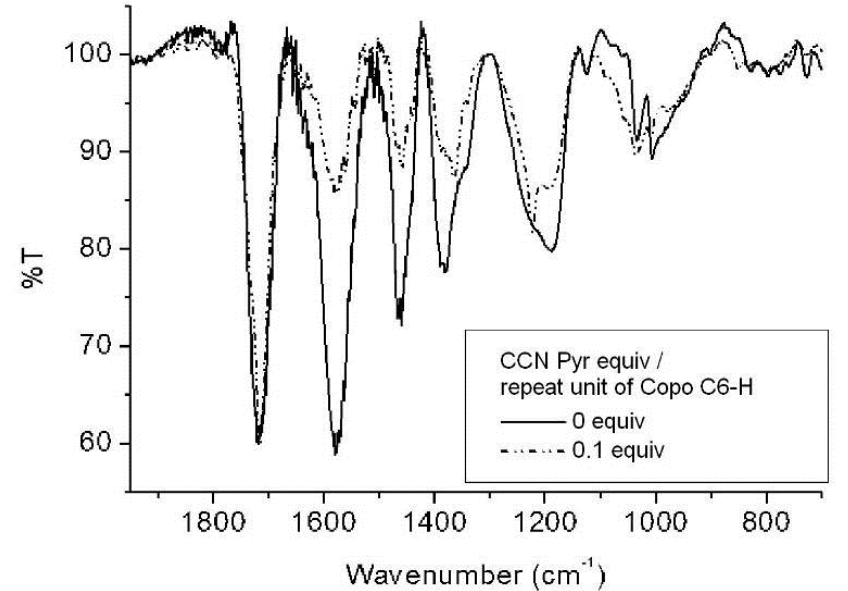
Figure 4. Selected IR spectra of “host-guest” materials Copo C other loadings are presented in Supplementary information, Figure